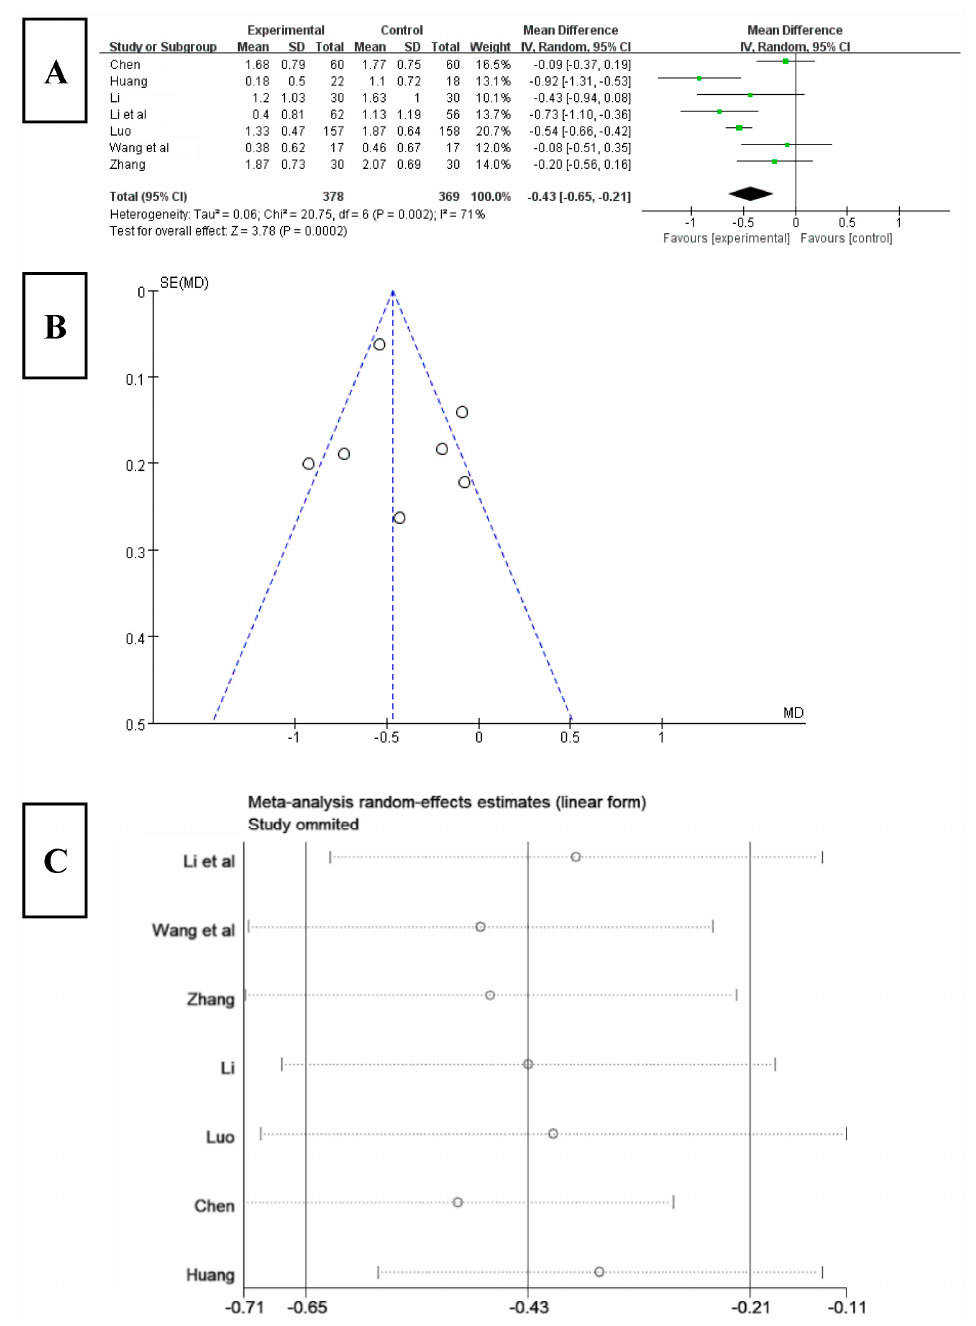
Figure 7. ( A ) Forest plot of sleep efficiency effect size. ( B ) Funnel chart of meta-analysis on sleep efficiency. ( C ) Sensitivity analysis of sleep efficiency effect size. efficiency. ( C ) Sensitivity analysis of sleep efficiency effect size